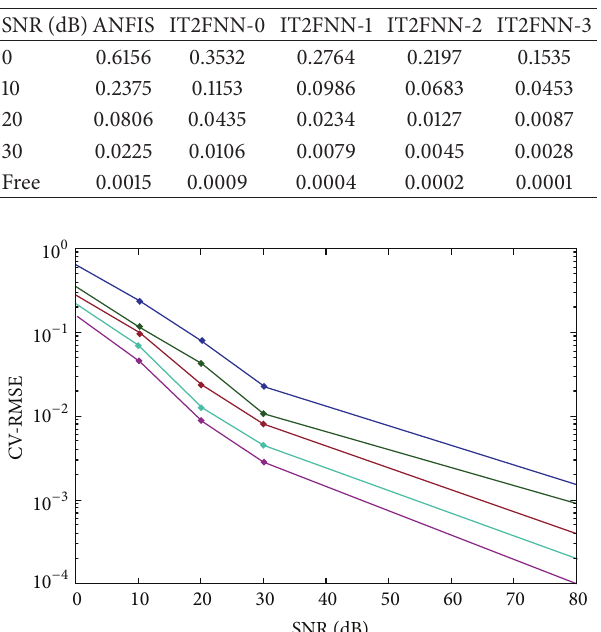
Table 1: RMSE (CHK) values of ANFIS and IT2FNN with 10-fold cross-validation for identifying non-linearity of Experiment 1.